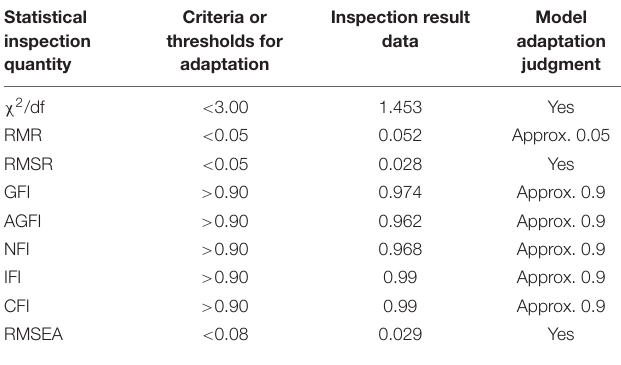
TABLE 4 | Fit indicators of confirmatory factor analysis